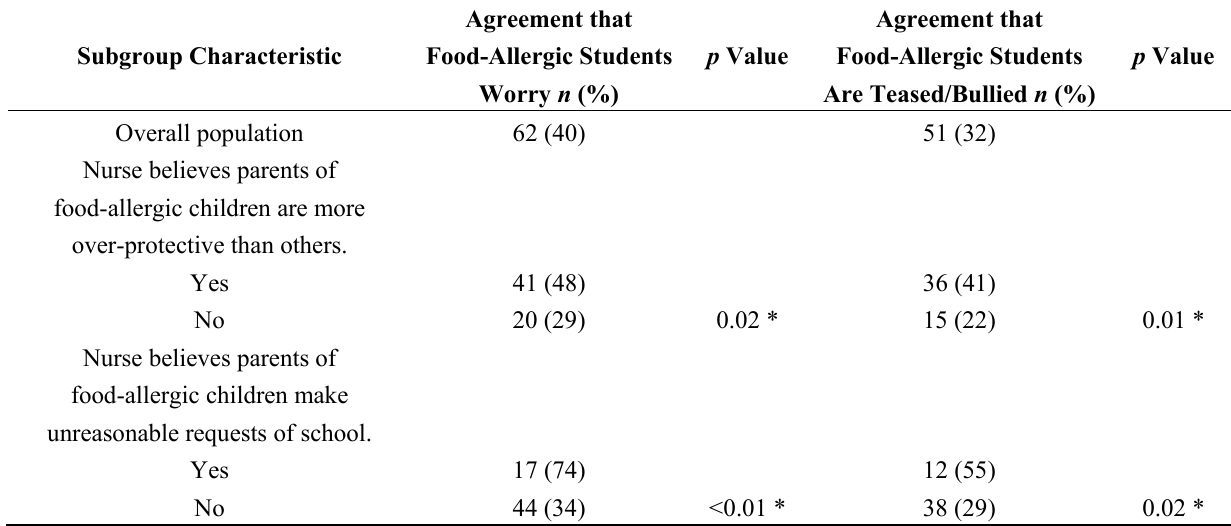
Table 6. Relationships of nurses’ parent and student